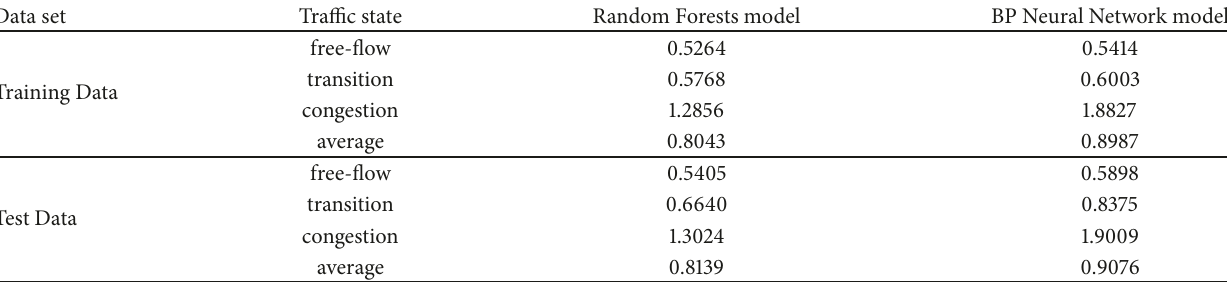
Table 9: The MAD of Random Forests model and BP neural network